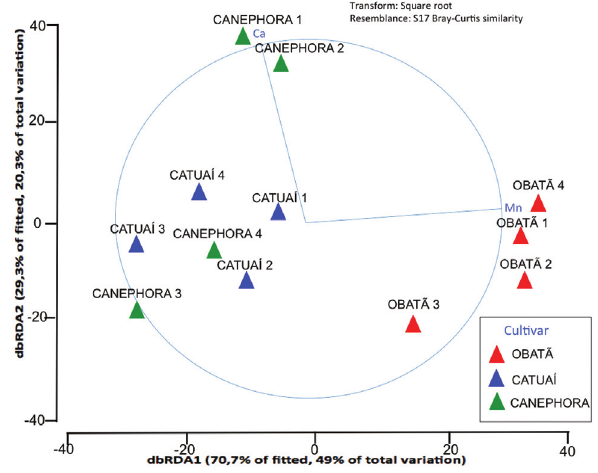
Figure 6 - Distance-based linear model (DistLM) analysis with fitted model, visualized using the distance-based redundancy analysis’ con- strained ordination (dbRDA) biplot of samples and environmental param- eter data. Samples were plotted as dbRDA coordinate scores and environ- mental data were overlaid as vectors to improve the visualization of correlations. 1 – Rest, 2 – Blossom, 3 – Early Fruit, 4 – Late Fruit.